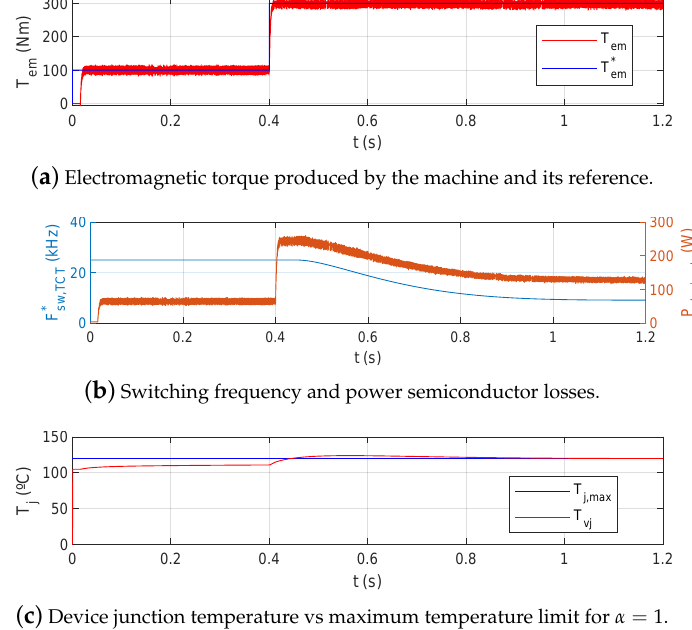
Figure 6. Simulation results obtained at very low speed and under a high torque step when using the TCT